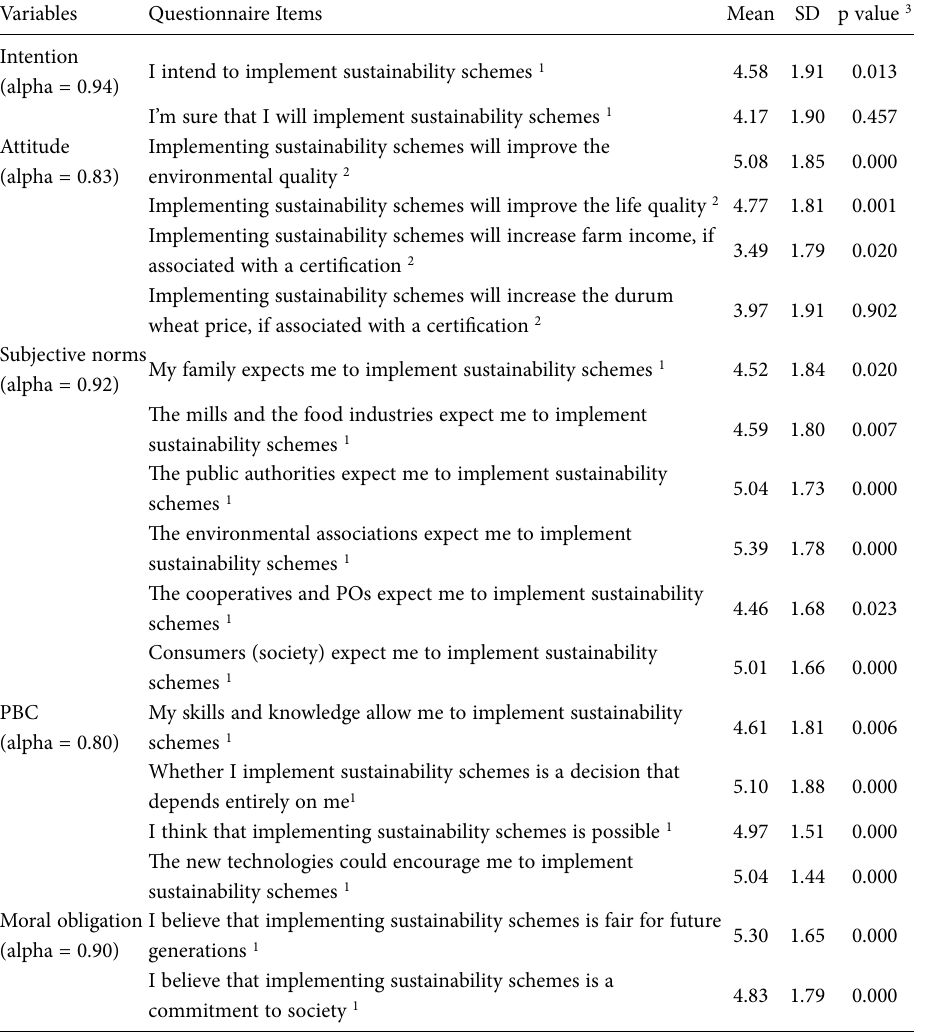
Table 4. Variables and questionnaire items of behaviour 2 “Sustainability scheme”, Cronbach’s alpha, means and standard deviations